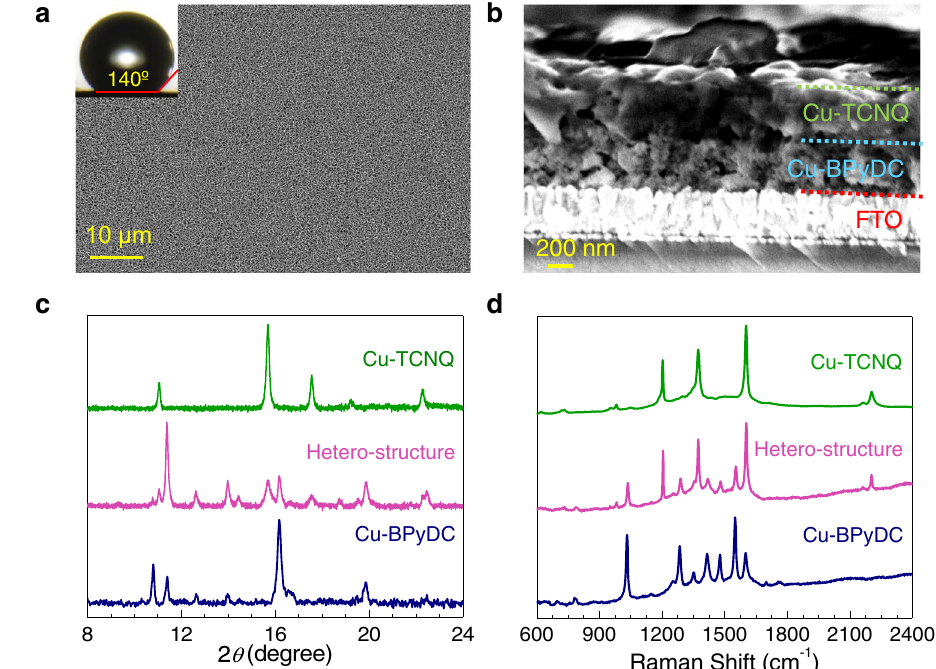
Fig. 2 | Morphology and structural analysis of pristine and hetero-structured thin fi lms. a FESEM image (top-view) showing highly-uniform coverage of the hetero-structured thin fi lm (inset: an optical image of the contact angle of water). b Cross-sectional FESEM image of hetero-structured Cu-TCNQ/Cu-BPyDC thin fi lm with identifying distinctive layers of FTO, Cu-BPyDC, and Cu-TCNQ (marked by